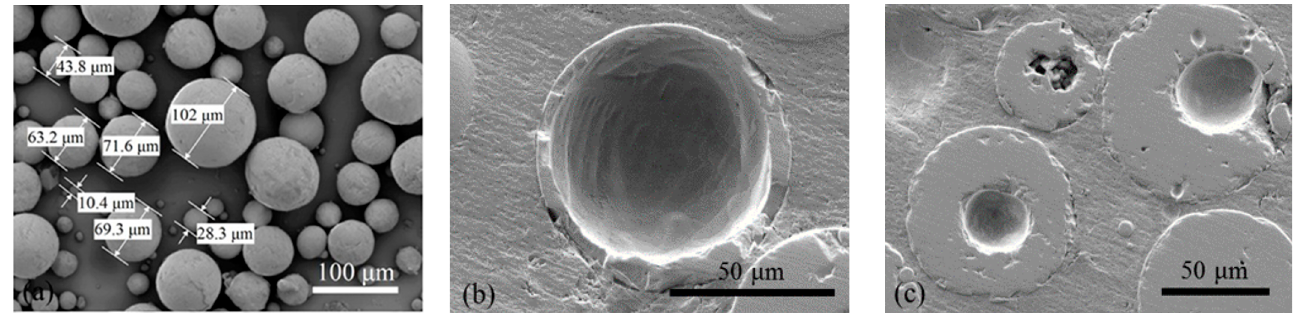
Figure 1. External ( a ) and internal ( b , c ) morphology of HCM (SEM images). SEM studies revealed that some of the HCM used in this work were solid. The hollow spheres had the wall thickness varying over a wide range (Figure 1b,c).